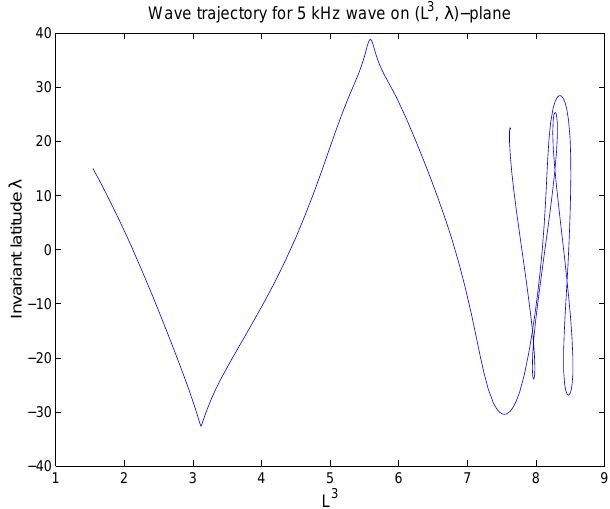
Fig. 4. Zoomed-in view of the ray trajectory showing how the arc-type of the trajectory in the reflection region changes to the loop-type as the wave propagation regime changes from a quasi- longitudinal to quasi-resonance one (cf. bottom right panel in Fig.